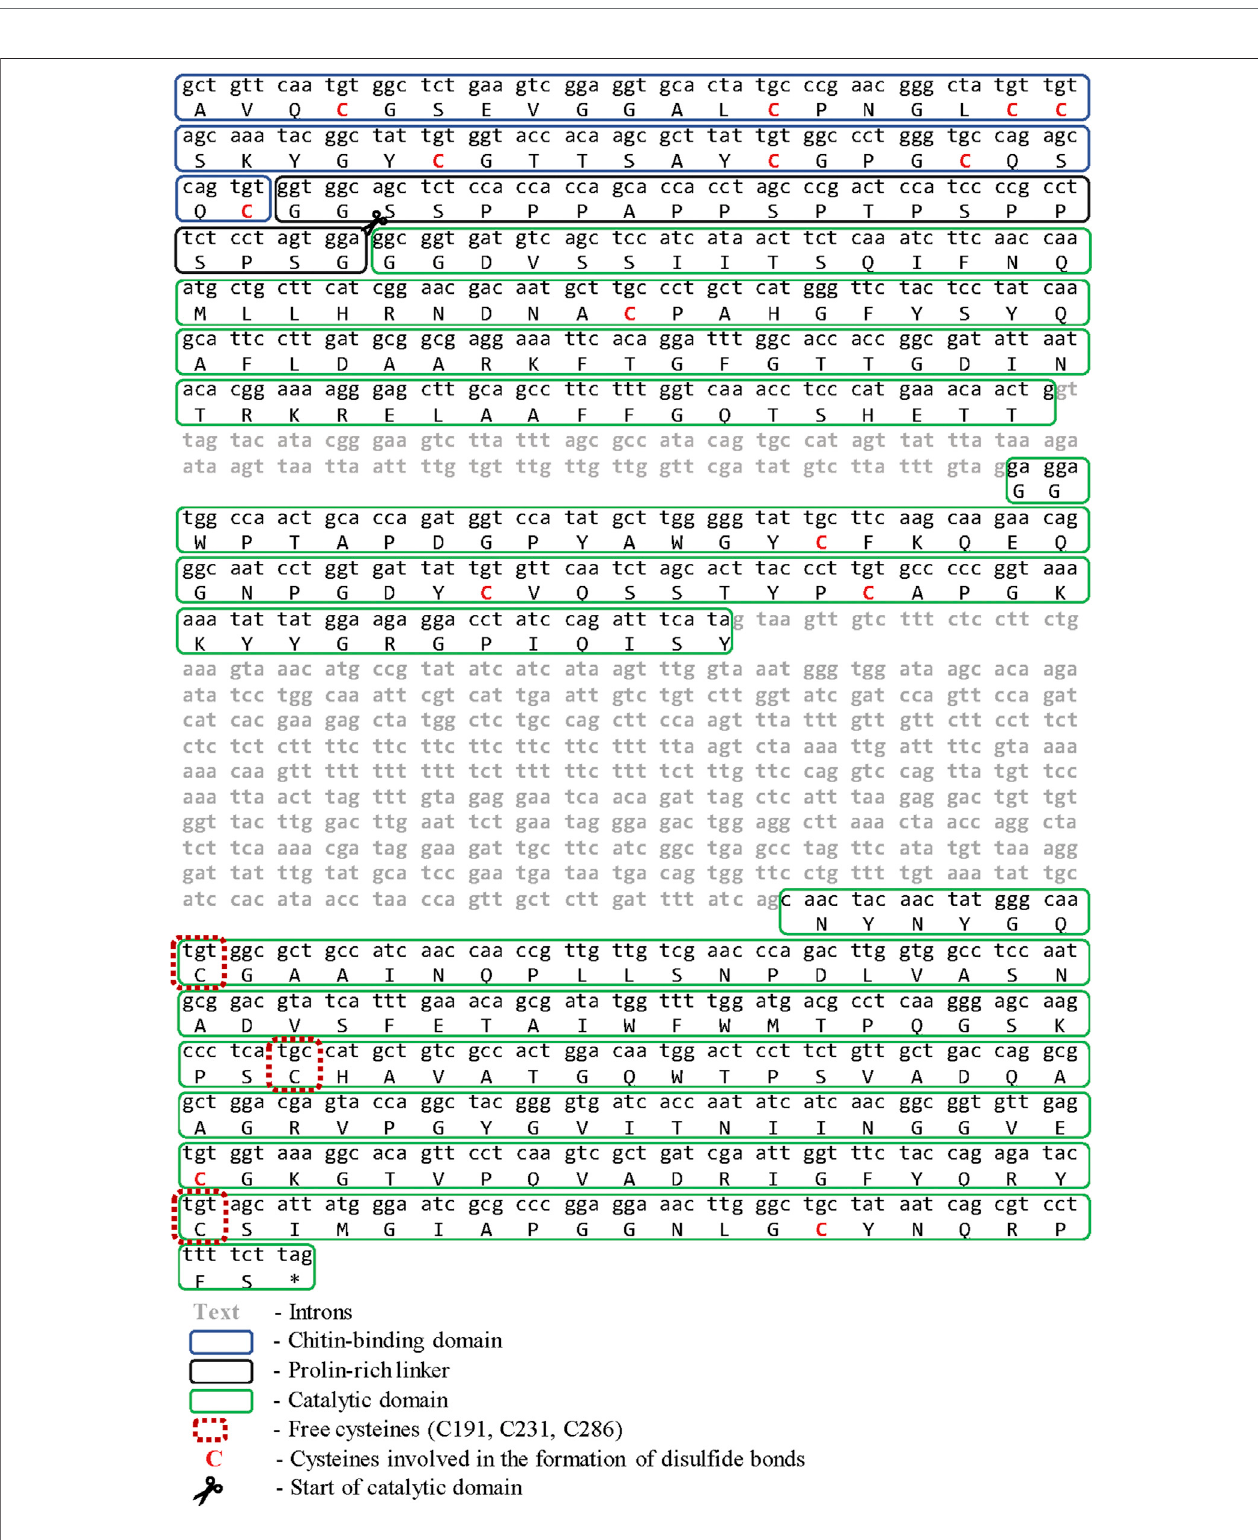
FIGURE 1 | - Nucleotide and amino acid sequence Chit19.